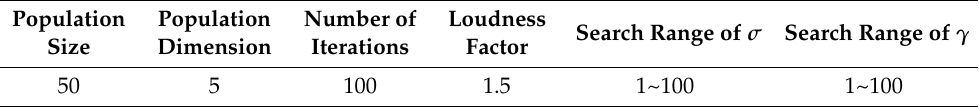
Table 3. Parameter setting for IBA.